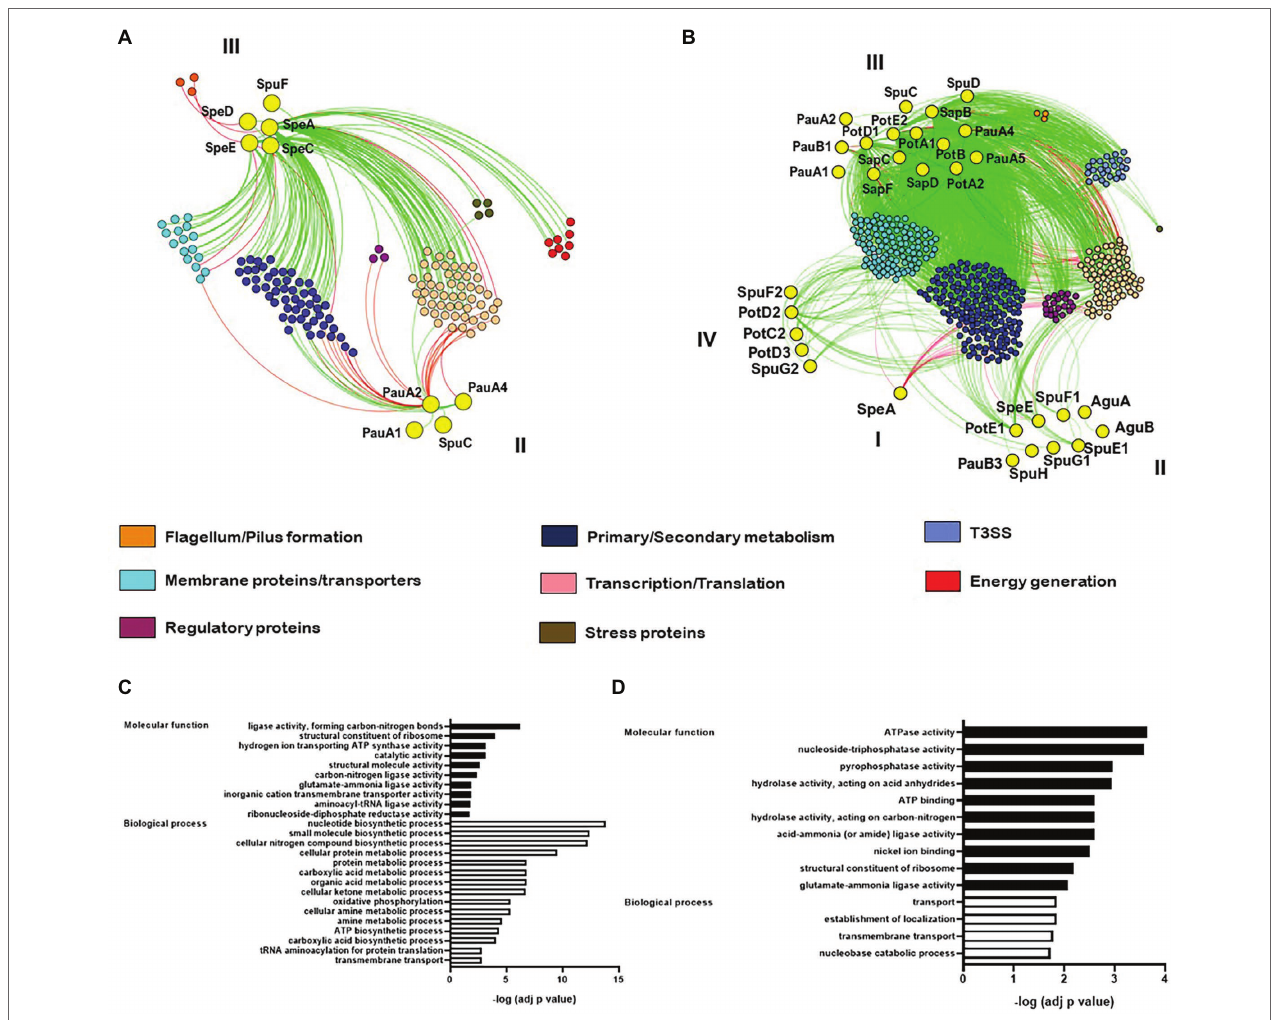
FIGURE 4 | mRNA co-expression networks in P. syringae pv. tomato DC3000 using the data sets from Nobori et al. (2018, 2020) (A) and in P. syringae pv. syringae B728a from Yu et al. (2013) (B) . Red and green edges denote negative and positive correlations, respectively, for highly correlated genes ( R 2 > 0.75 was considered for Nobori et al., 2018, 2020; whereas R 2 > 0.99 was considered for Yu et al., 2013). Functions are color-coded. Pearson’s correlation coefficients were used. Bar graphs in (C, D) depict GO enrichment analysis of the genes included in (A, B) ,